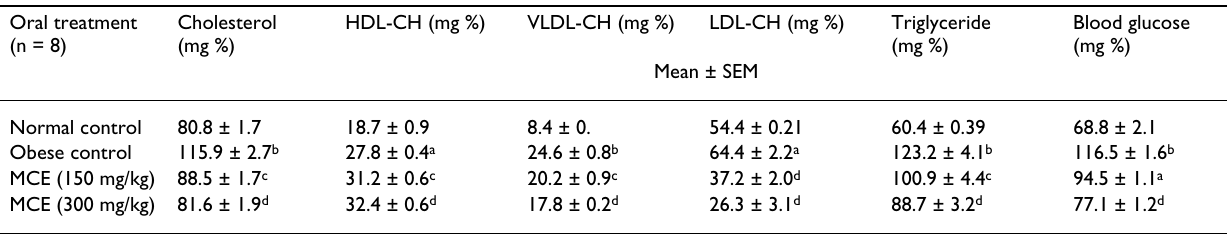
Table 3: Effect of MCE on the serum lipids and blood glucose levels in old obese rats Oral treatment (n =